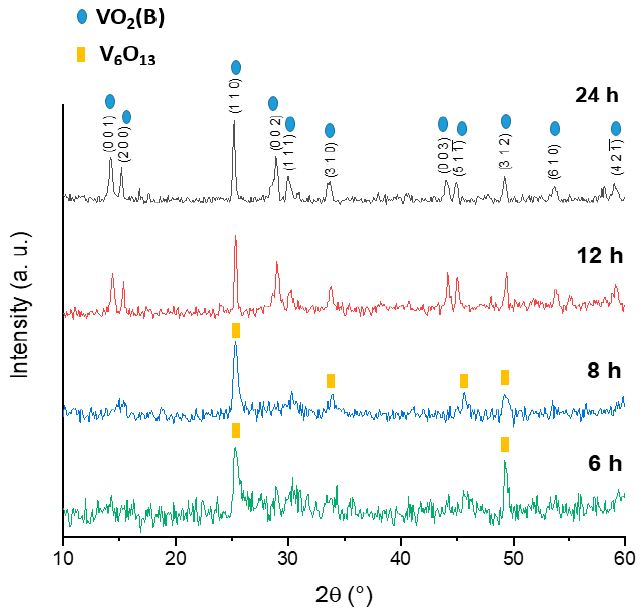
Figure 1. Superimposition of the XRD of the following samples: V4 1.7 _24h, V5 1.7 _12h, V6 1.7 _8h, V7 1.7 _6h (Cu anode).